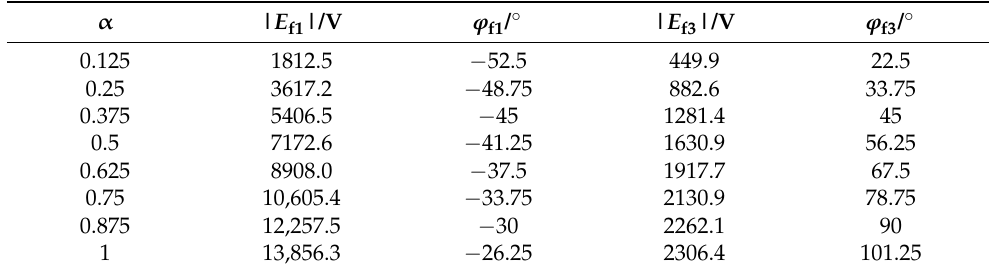
Table 2. Fault potential of the simulated generator.